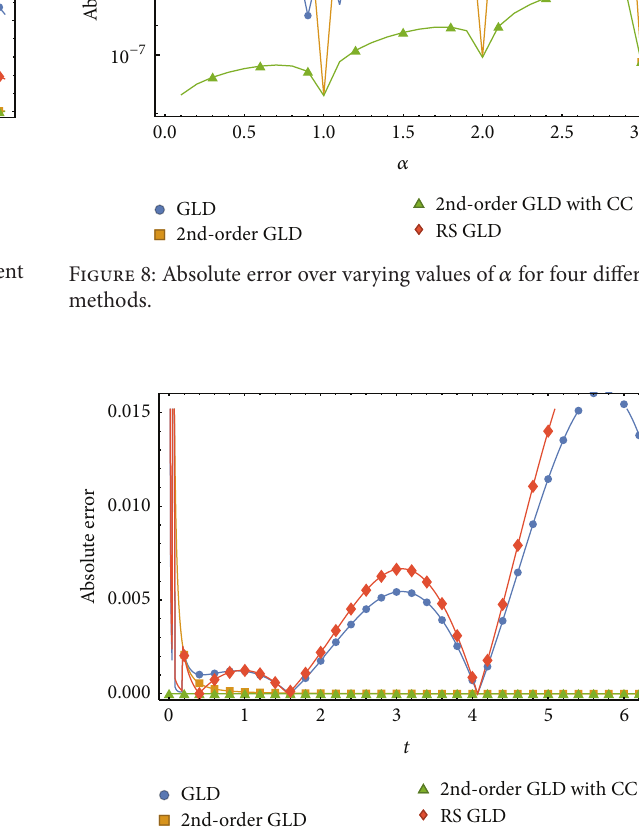
Figure 9: Absolute error over time domain for four different methods.